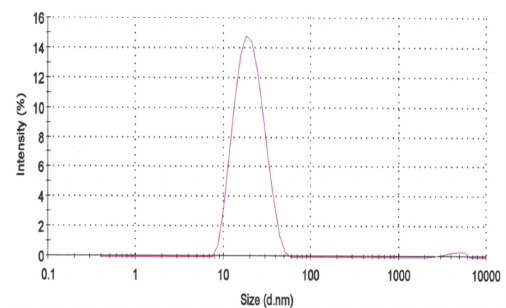
Fig. 7. UV– Vis spectra of CuO-NiO nano-composites after